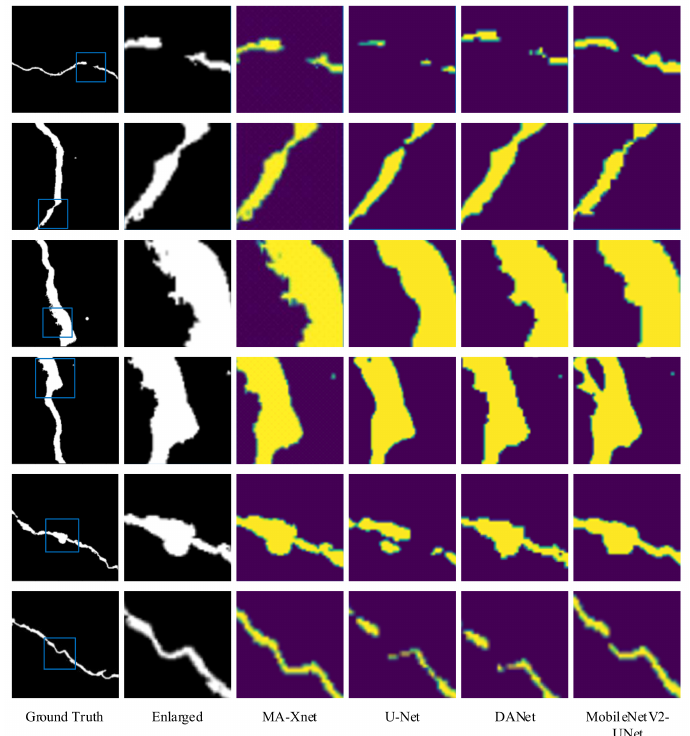
Figure 9. Detailed feature comparison diagram.